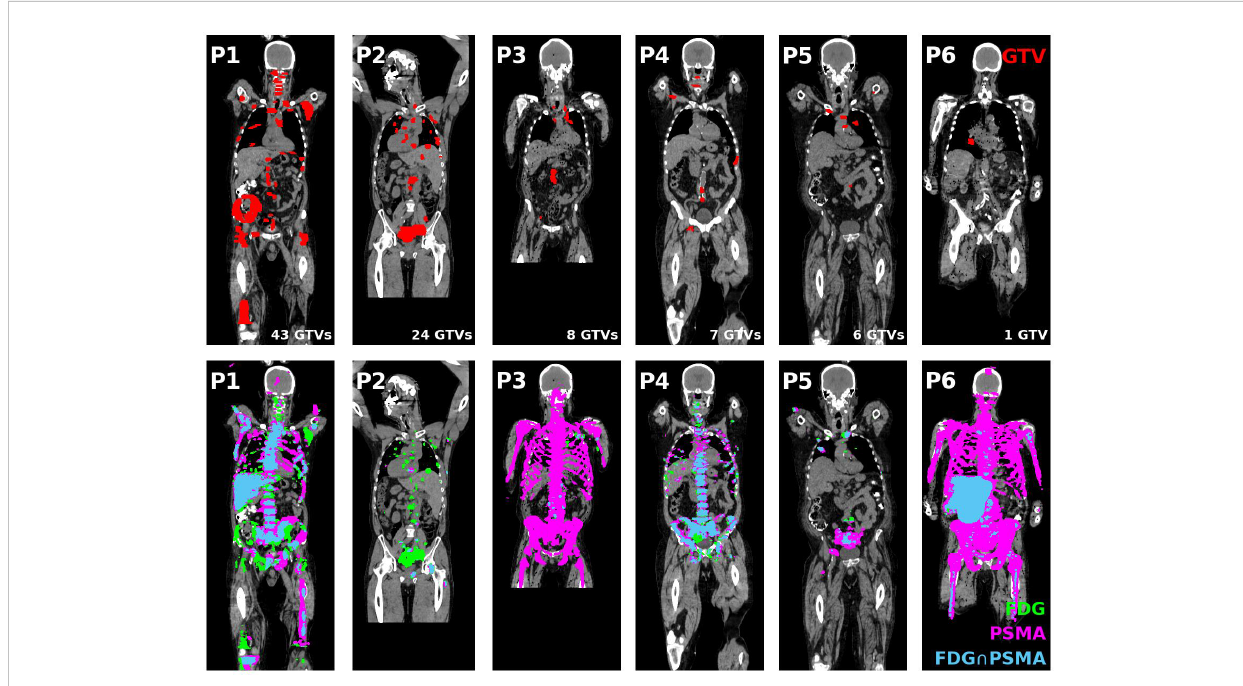
FIGURE 1 (Top tow) GTV contours (red) of all coronal slices projected on the middle coronal slice for all patients included in this study. (Bottom row) FDG (green) and PSMA (magenta) PET distribution and their intersection (blue) projected on the middle coronal slice for each patient. GTV, Gross tumour volume; FDG, 18 F- fl uorodeoxyglucose; PSMA, Prostate speci fi c membrane antigen; PET, Positron emission